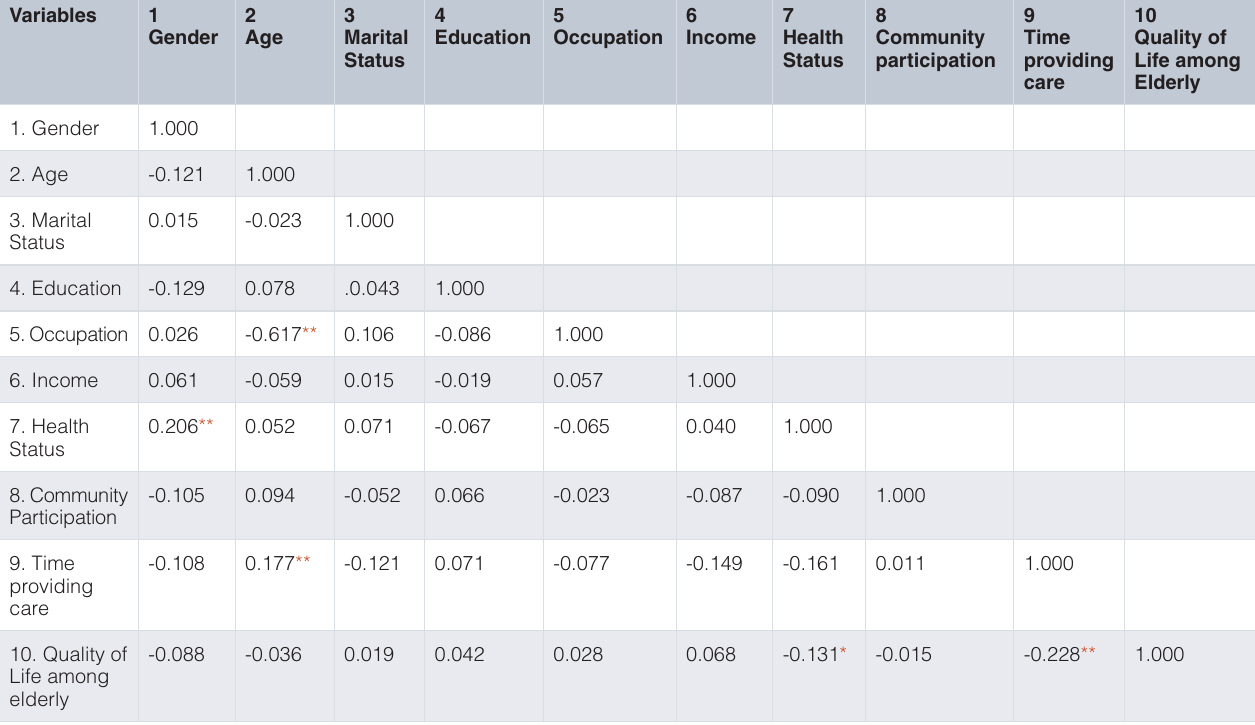
Table 4. Correlation coefficient and relationship between predictors shown by correlation matrix.